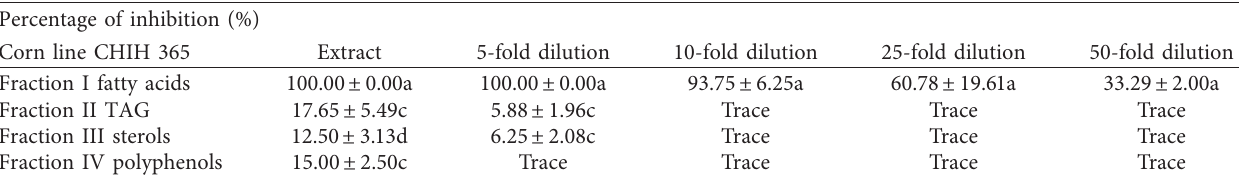
Table 6: Antidiabetic activity of the tested extracts (obtained after conducting preparative thin-layer chromatography) expressed in % inhibition of α